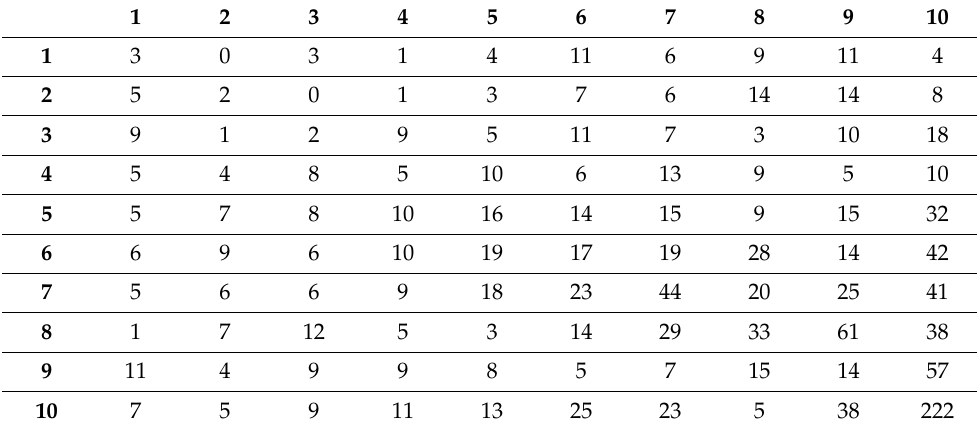
Table 7. Number of companies in individual clusters for the year 2018.